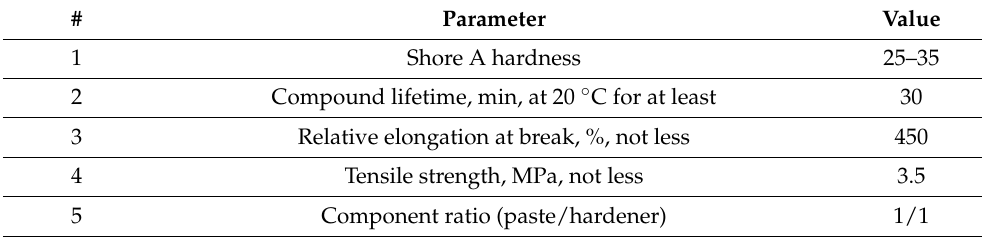
Table 1. Characteristics of silicon-organic compound Silagerm